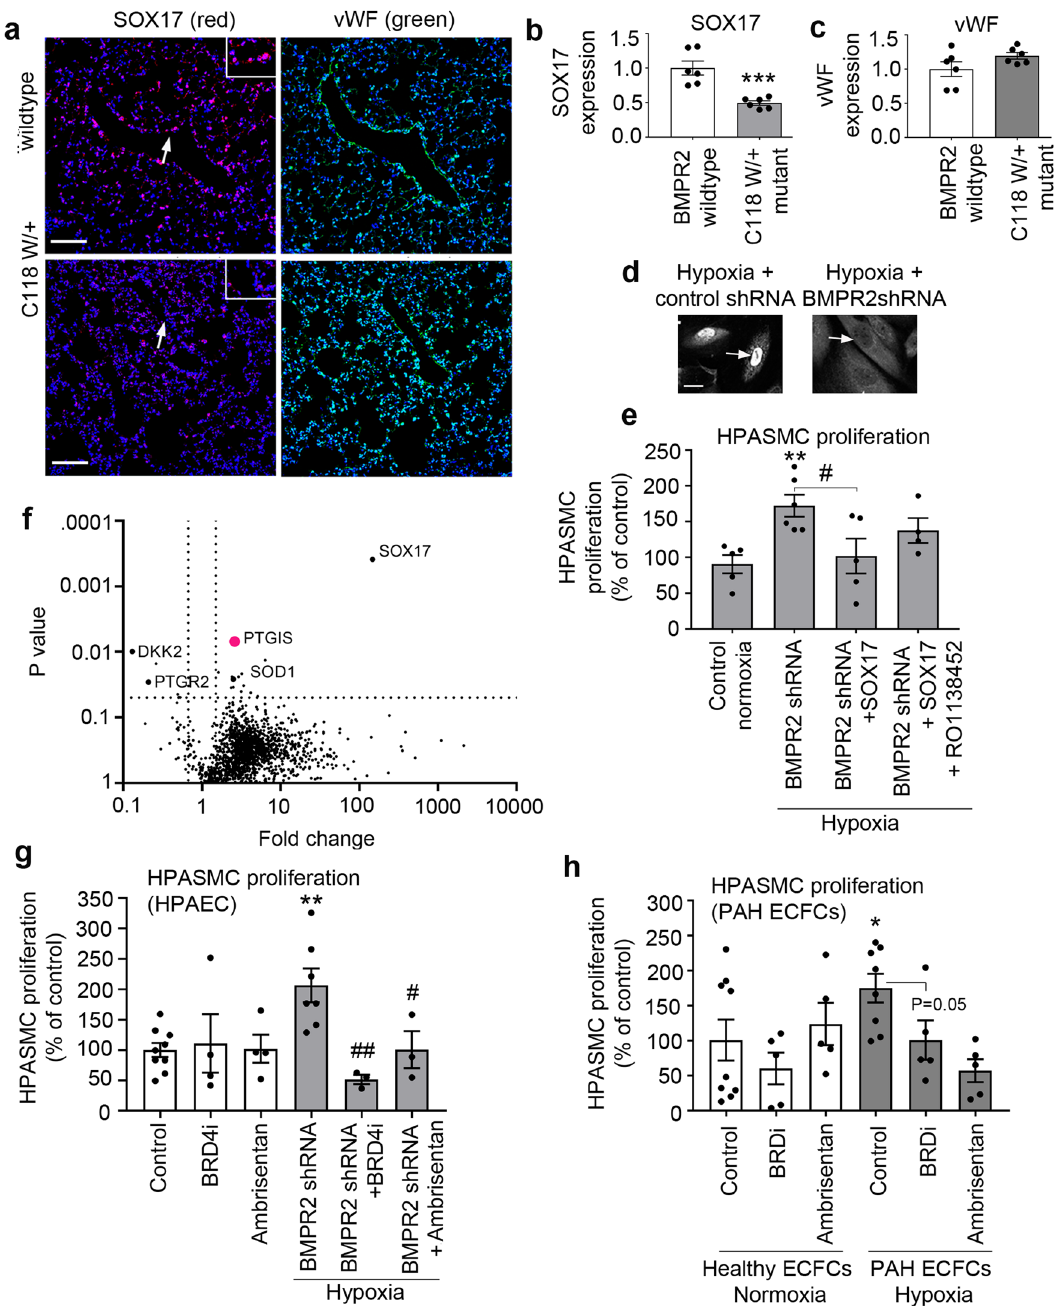
Fig. 7 Endothelial SOX17 regulates PASMC proliferation in the two-hit PAH model. a Representative confocal images of lung sections of wildtype and BMPR2 (C118W/ + ) mice with SOX17 (red) and vWF marking endothelium (green) and nuclei in blue (DAPI), as indicated; Bar = 50 µ m. Arrows point to cell nuclei. Magni fi ed images of boxed areas are shown in the top right corner. b , c Corresponding graphs showing SOX17 and vWF expression in mouse lung tissues, as indicated. d Confocal images showing localisation of SOX17 in BMPR2-de fi cient HPAECs (BMPR2 shRNA) and controls (control shRNA), as indicated. Arrows point to cell nuclei. Bar = 10 µ m. e Volcano plot showing SOX17-induced DE proteins, with prostacyclin synthase (PTGIS) marked in pink and selected proteins of interest highlighted. f Effect of endothelial SOX17 overexpression on HPASMC proliferation in the two-hit model (BMPR2shRNA + hypoxia) model, with and without prostacyclin receptor inhibitor, RO1138452 (10 µ M). g , h Effect of Ambrisentan and BRD4 inhibitor AZD5153 on HPASMC proliferation in two-hit models of PAH, utilising BMPR2-de fi cient HPAECs or PAH ECFCs, as indicated. In b , c n = 6/group. *** P < 0.0001, Student t -test; In e n = 4 – 6, * P < 0.05 comparison with normoxic control, # P < 0.05, comparison as indicated; one-way ANOVA with Tukey post-test. In g n = 4 – 8, in h n = 5 – Patient blood-derived endothelial colony-forming cells (ECFCs) of BMPR2-depleted HPAECs. The comparative analysis of cell display abnormalities characteristic of PAH, raising interest in their responses revealed several important similarities between the two application in personalised medicine 20,21 . To validate our model, cell types. Consistent with changes seen in BMPR2-de fi cient we used patient ECFCs with disabling BMPR2 mutations in place HPAECs, ECFCs with BMPR2 mutations showed upregulation of